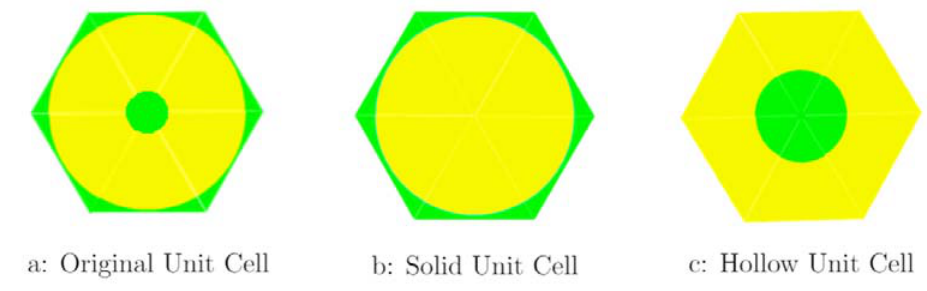
Figure 2: Investigated unit cells (yellow - graphite, green - fuel salt)